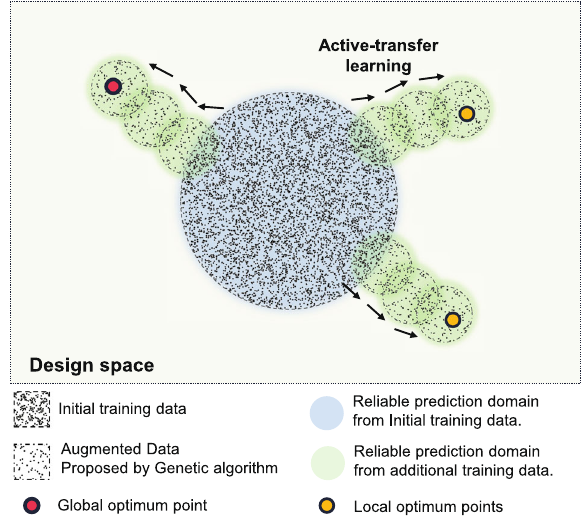
Fig. 1 Schematic of deep learning framework for material design space exploration. Schematic of gradual expansion of reliable prediction domain of DNN based on the addition of data generated from the hyper-heuristic genetic algorithm and active transfer